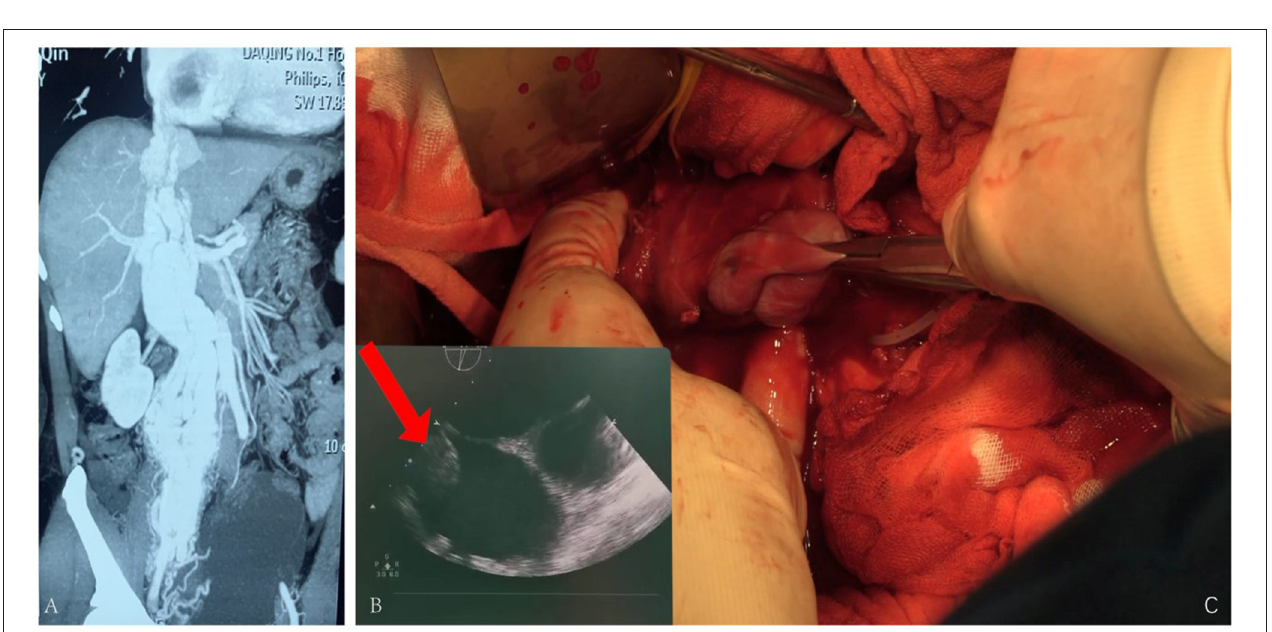
the pelvic AVF at the time of removing the intravenous tumor (16). In these cases, AVF was found at the same time when IVL was diagnosed, yet few treatments were done for the